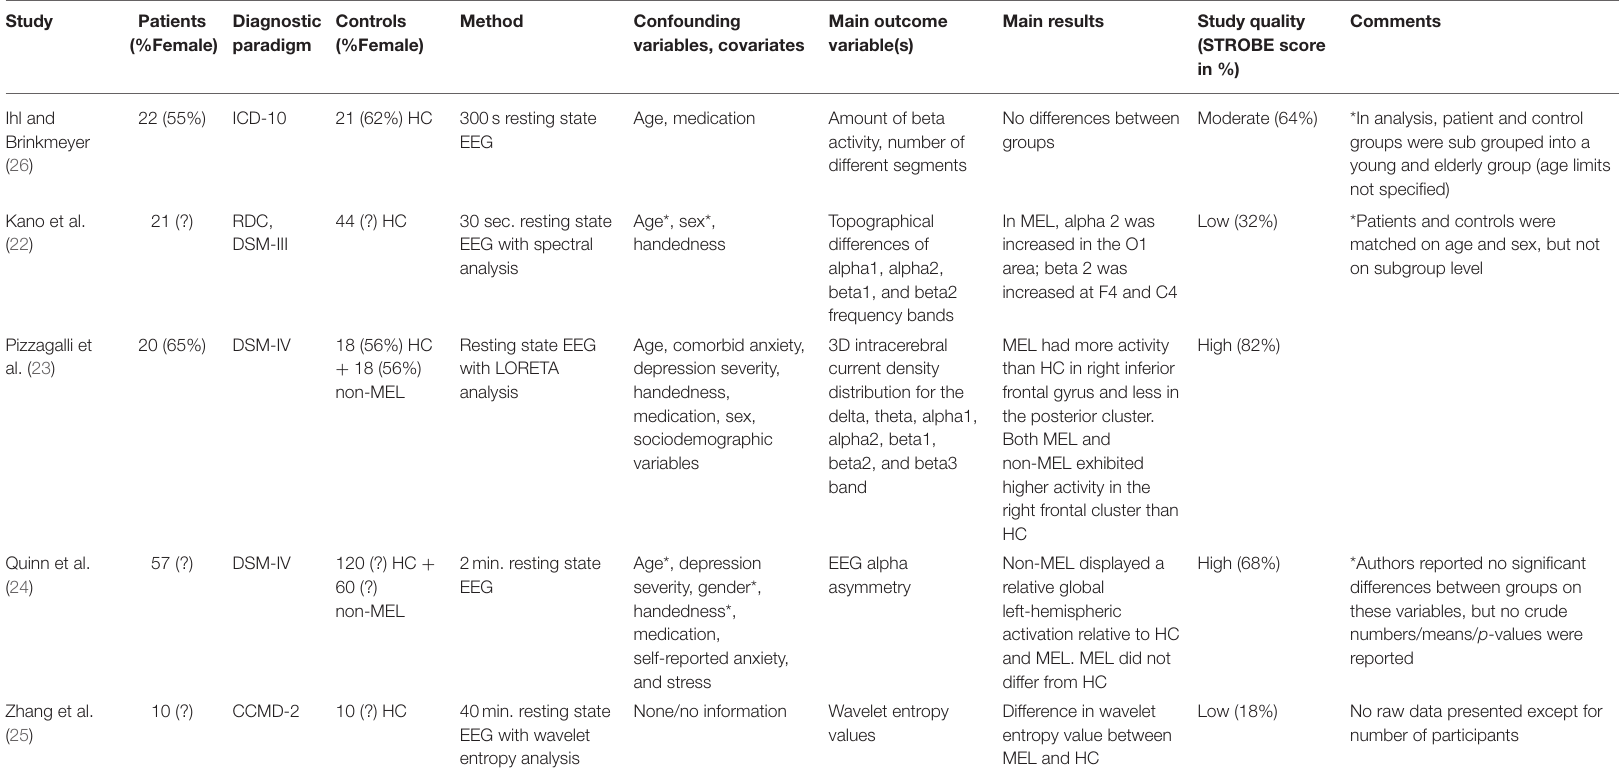
TABLE 1A | Summary of resting state